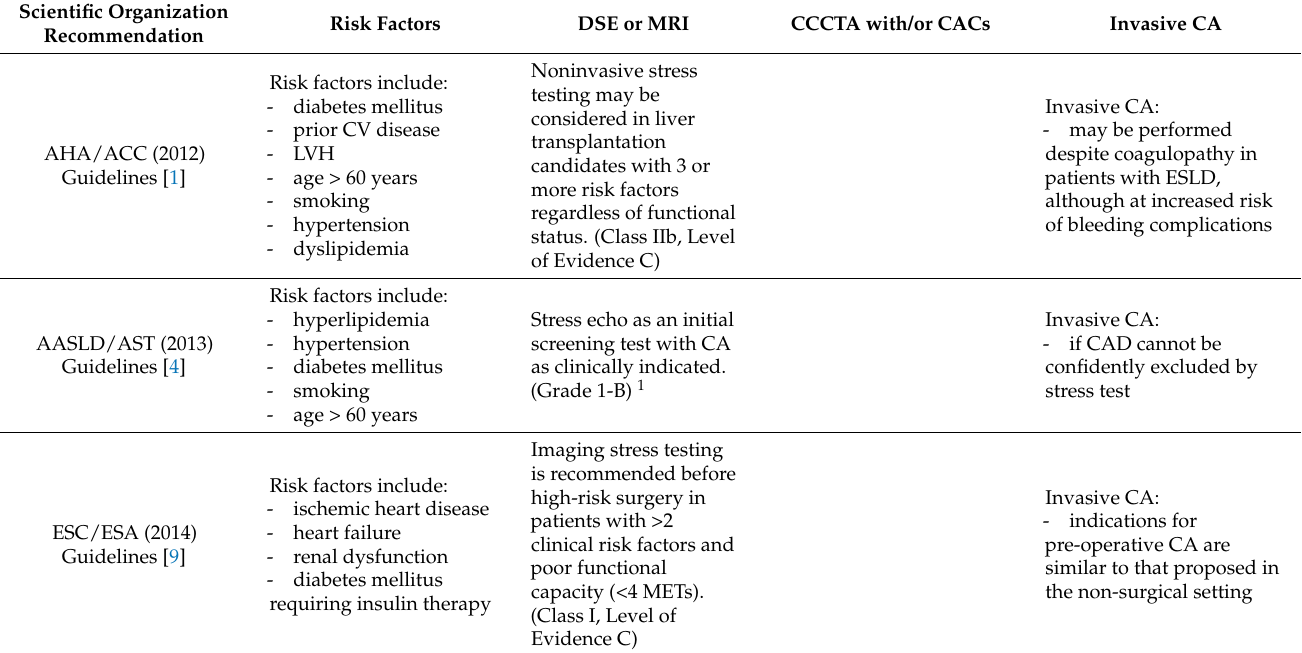
Table 2. Guidelines and recommendations for CAD risk assessment prior to